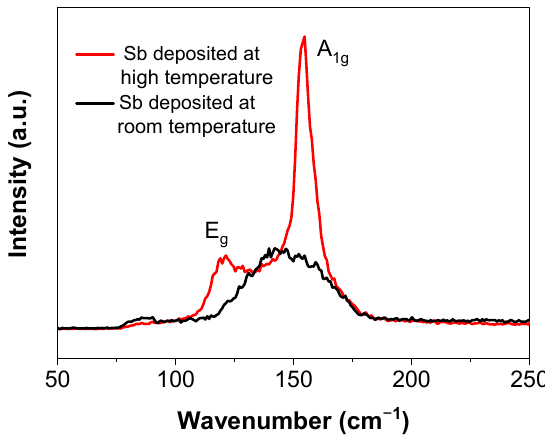
Figure 2. Raman Spectra of Sb films deposited at different temperatures.